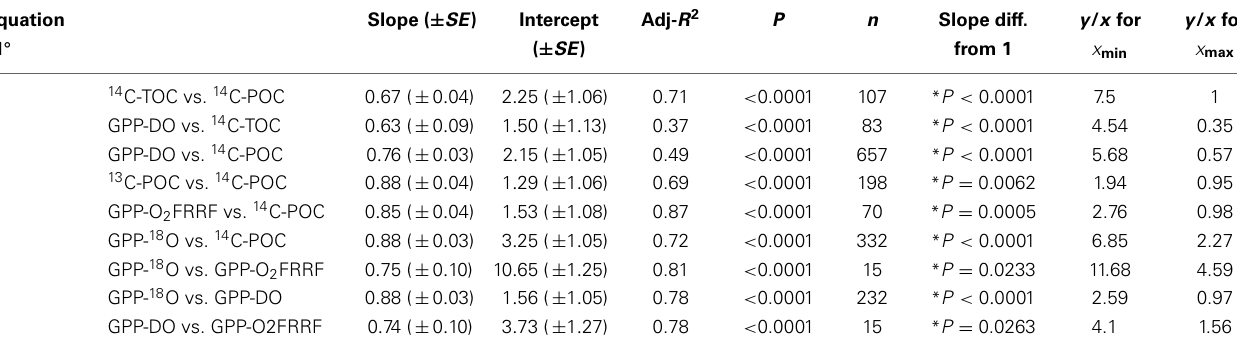
Table 4 | Principal component RMA regression equations of the form PP y = aPP b x showing the relationship between the log primary production estimates derived in parallel using different methods, along with the corresponding adjusted coefficient of determination (Adj- R 2 ), the associated probability ( P ), the probability P of the F -test testing if the slope is different from 1 ( * represents the significant difference of the slope from 1), and the y / x (i.e., aPP b x /PP x ) ratio for the minimum and the maximum values of x .